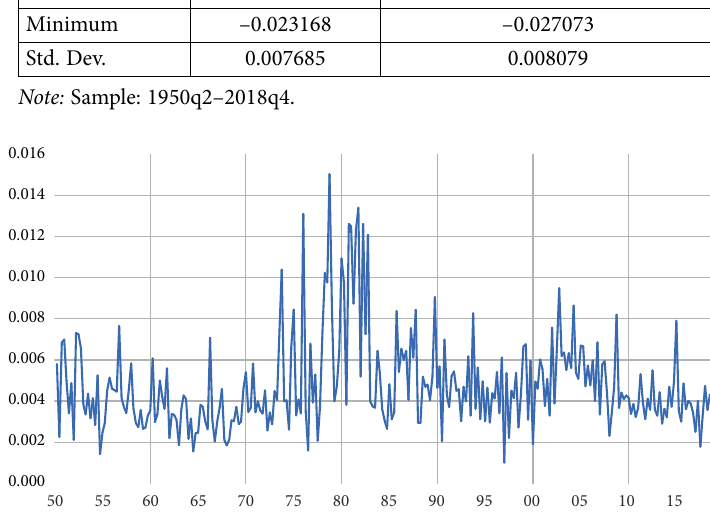
Figure 2. Standard deviation of regional inflation